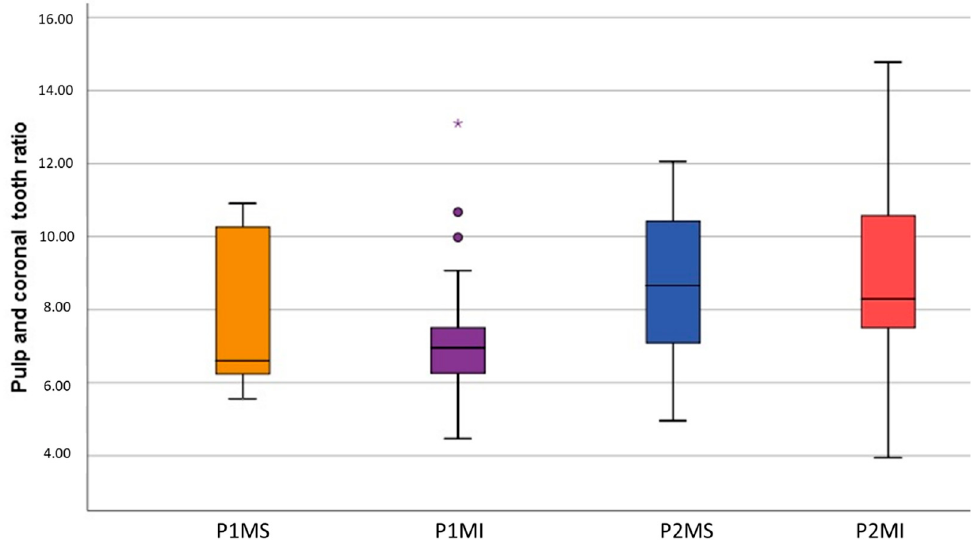
tween pulpal and coronal volumes were 24.44 and 27.69, respectively, in the P1MS, 26.46 and 30.46 in the P1MI, 37.51 and 41.10 in the P2MS, 39.17 and 44.59 in the P2MI (Figure 10).